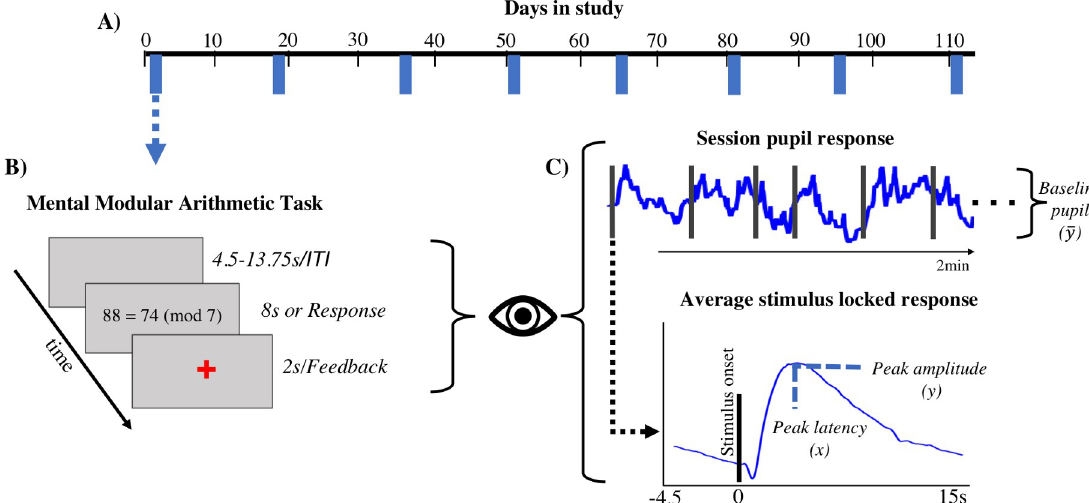
Fig 1. Top: A) Participants completed the modular mental arithmetic task on 8 separate biweekly sessions over the course of 16 weeks. B ) During the modular mental arithmetic task participants evaluated statements by subtracting the two numbers and indicating whether the remainder was divisible by the modulo. C ) Baseline, peak amplitude, and peak latency features were extracted from the pupil